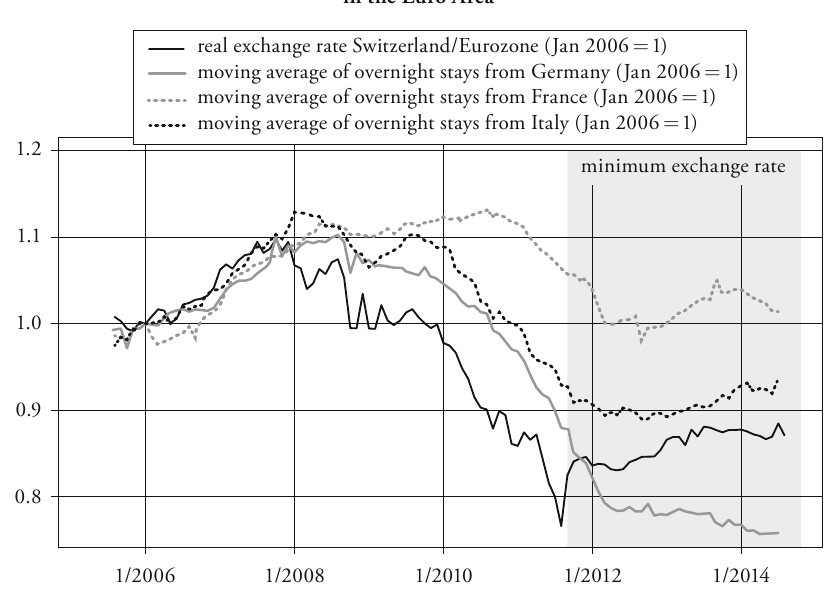
Figure : Correlation between the Real Exchange Rate and Overnight Stays in the Euro